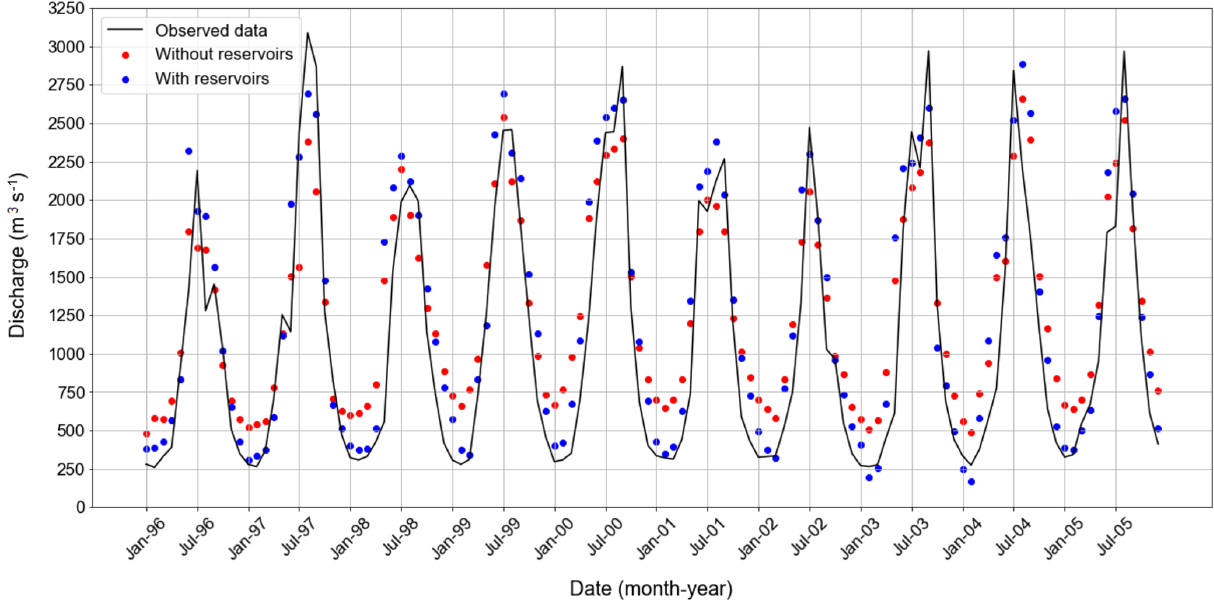
Figure 9. Comparison between observed and simulated monthly discharges at Jiuzhou station over the period 1996–2005. Simulated data are produced by the two selected models with and without reservoirs (blue and red dots, respectively).